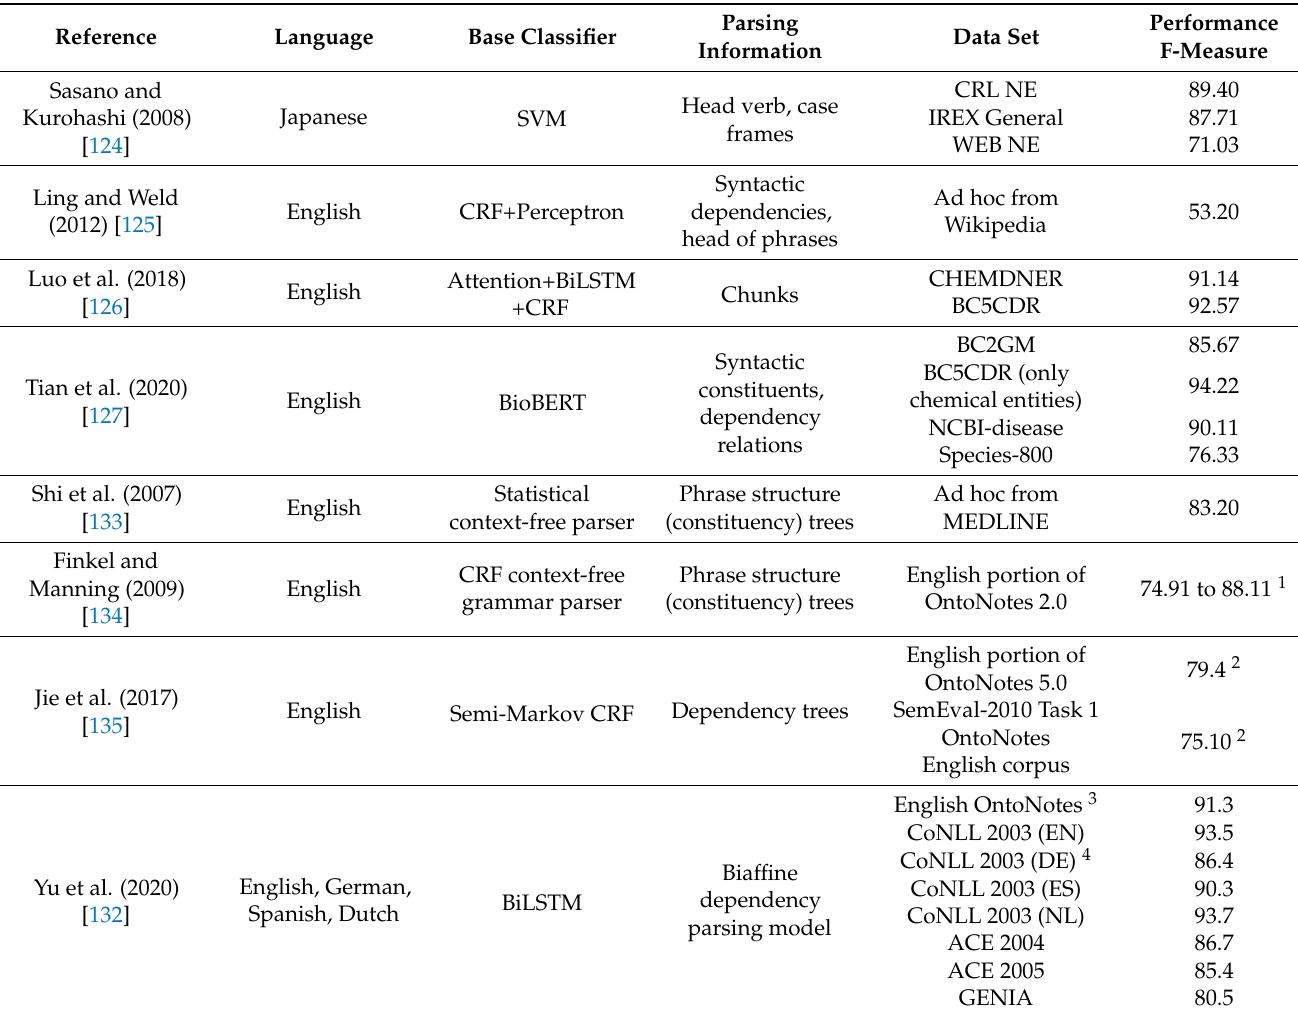
Table 1. Main characteristics of named entity recognition (NER) systems using parsing